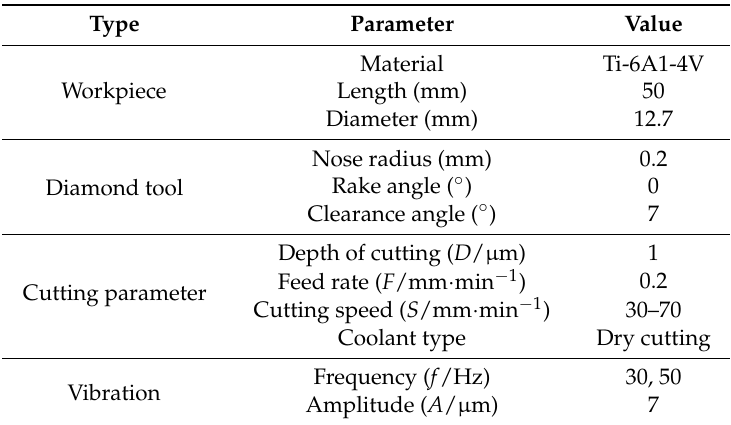
Table 1. The specific experimental